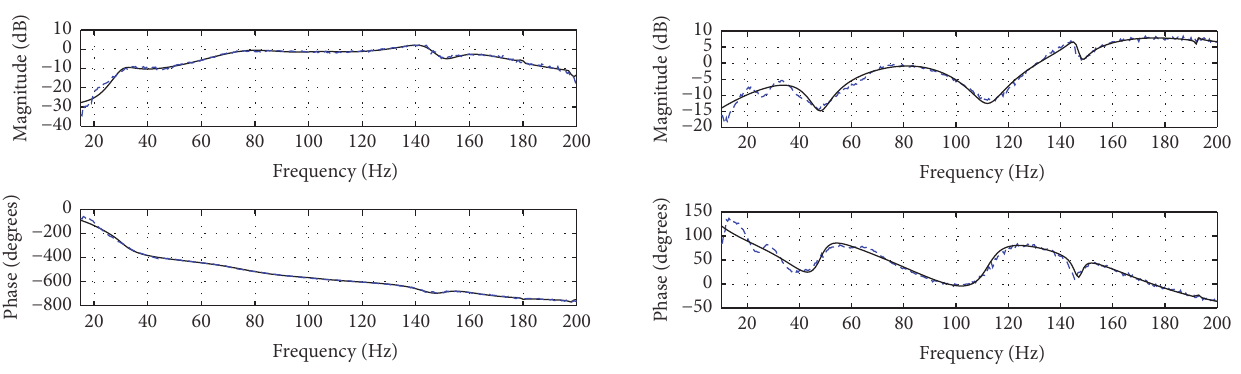
Figure 5: Frequency response curves of VA22 experiment model and identification system model.